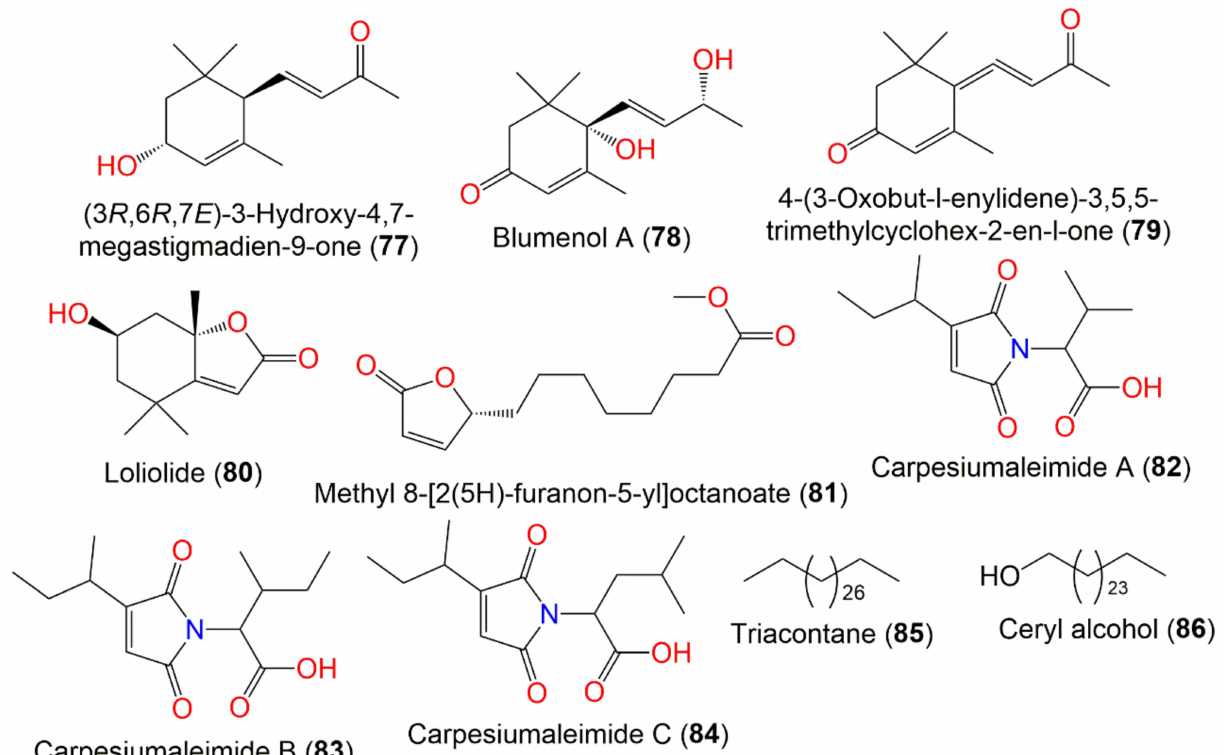
Figure 13. Other metabolites ( 77 – 86 ) reported from C. abrotanoides . The UPLC-QTOF-MS analysis of the roots’ petroleum ether fraction led to the charac- terization of 12,13-epoxylinolenic acid ( 87 ), (5E,10E)-6,10,14-trimethyl-pentadeca-5,10,13- trience-2,12-dione, γ -linolenic acid ( 88 ), α -linolenic acid ( 89 ), 5 α -hydroxy-7 α H,11 α H- eudesm-4(15)-en-12,8 β -lactone ( 90 ), and palmitic acid ( 91 ) [17]. In 1989, Kameoka et al. analyzed the essential oil of Japanese C. abrotanoides herb obtained by steam distillation us- ing GCMS, IR, GC, and 1 H NMR. The oil had a fatty acid odor and contained β -bisabolene ( 92 ) and C2~C16 carboxylic and C18 fatty acids as major components. Additionally, dihy- droactinidiolide ( 93 ), γ -nonalactone ( 94 ), C 3 ~C 14 aliphatic alcohols, butylphthalide ( 95 ), and aldehydes were identified [67] (Figure